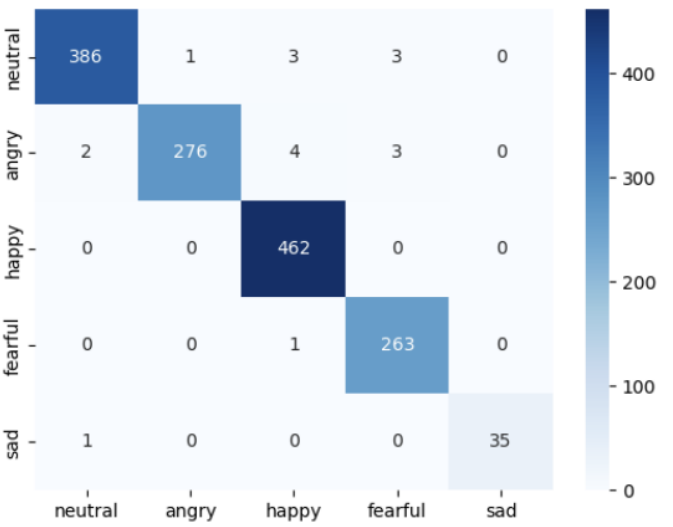
Figure 8. Emotion predictions on original and Transformed sounds from RAVDESS dataset.